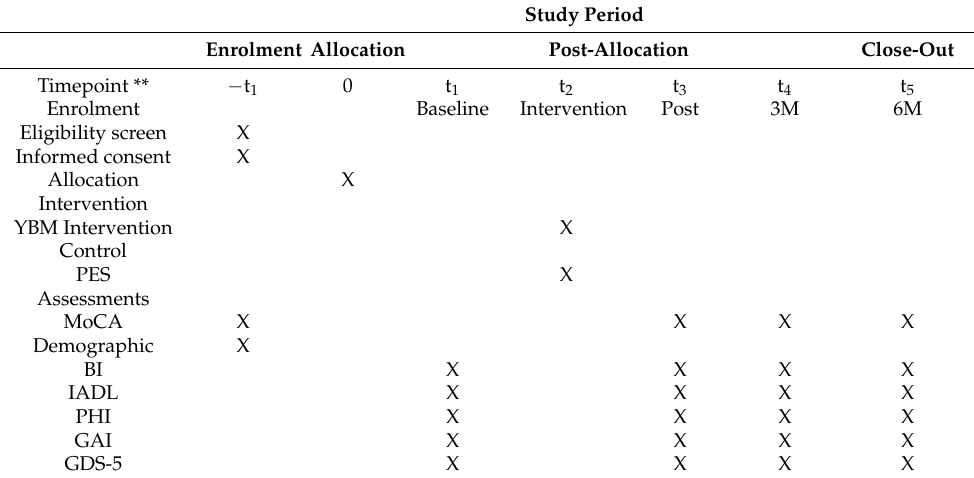
Table 1. Participants